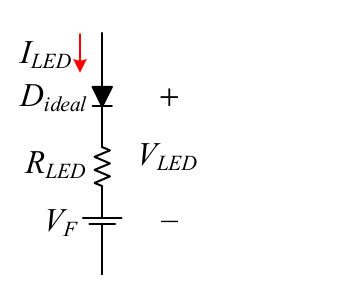
Figure 5. Approximately linear model of an LED string.